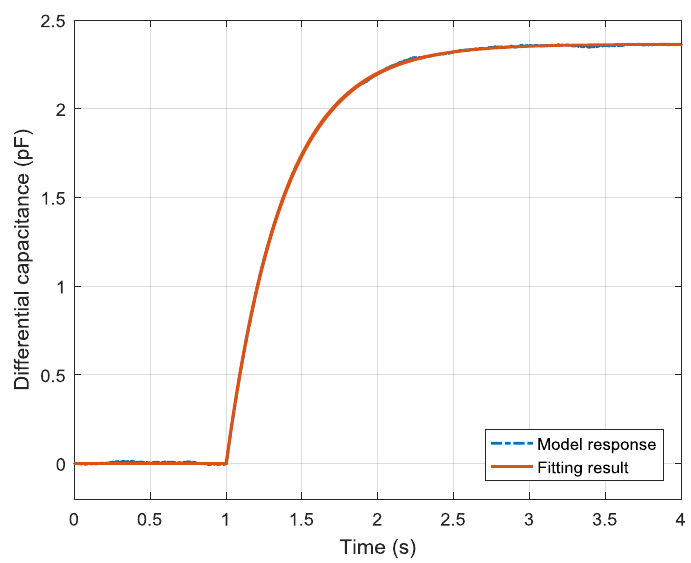
(cid:16) (cid:17) 0, 30 2 aF.